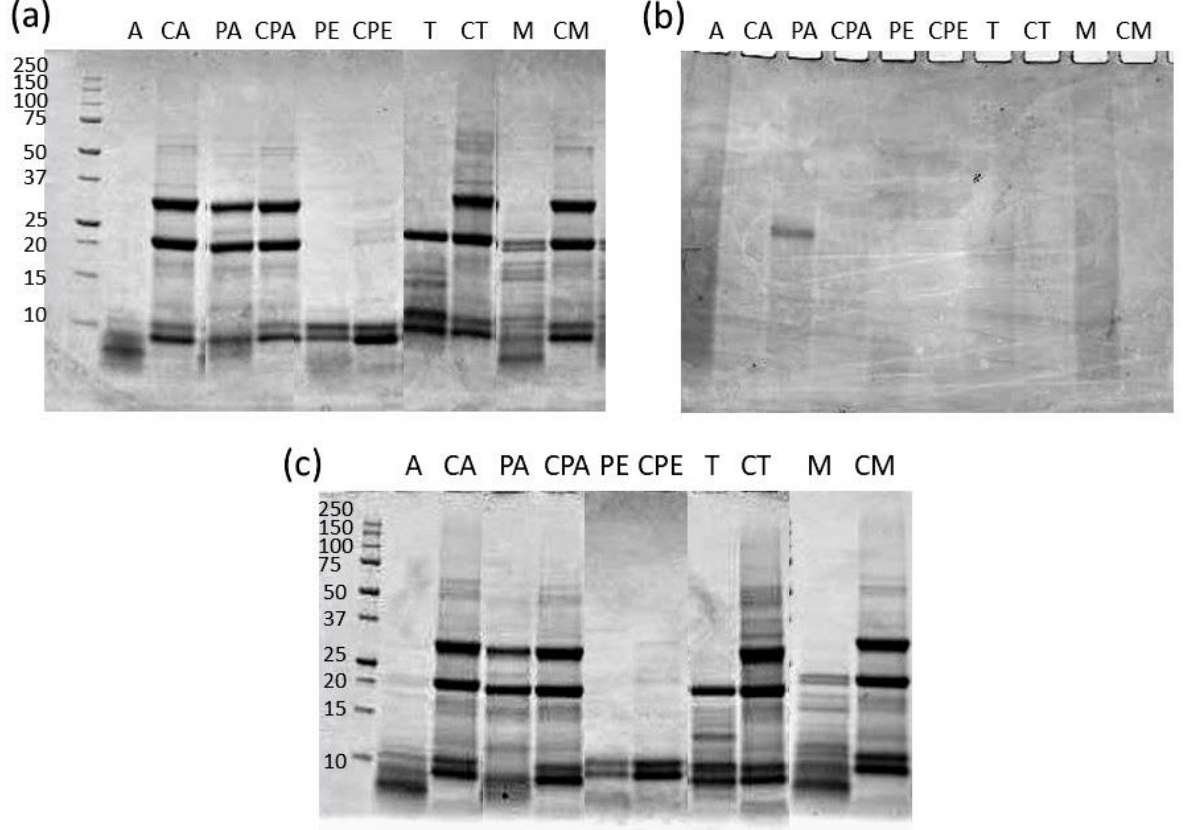
Figure 4. SDS-PAGE of the protein extracts obtained with enzyme-assisted extraction and aqueous extraction from: ( a ) defatted CGB, ( b ) CSS, ( c ) raw CGB. A: Bacillus licheniformis protease, PA: papain, PE: pepsin, T: trypsin, M: mix (Bacillus licheniformis protease and papain). The same codes preceded by “C” (control) indicate the aqueous extraction carried out under the same pH and temperature conditions as the respective enzyme-assisted extraction but without enzymes. The molecular weight marker is on the left (kDa).